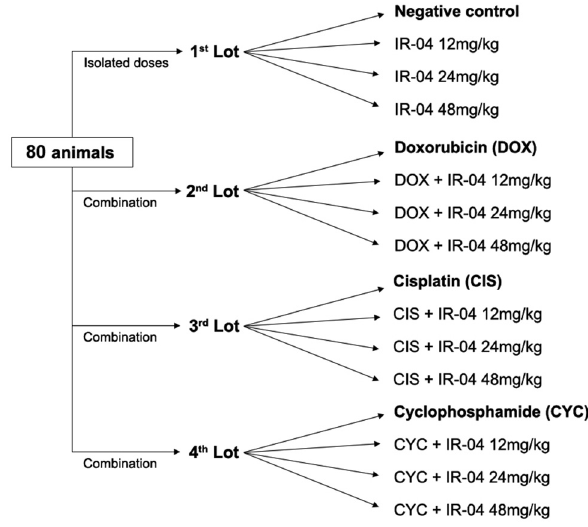
Figure 5 - Experimental design (doses and